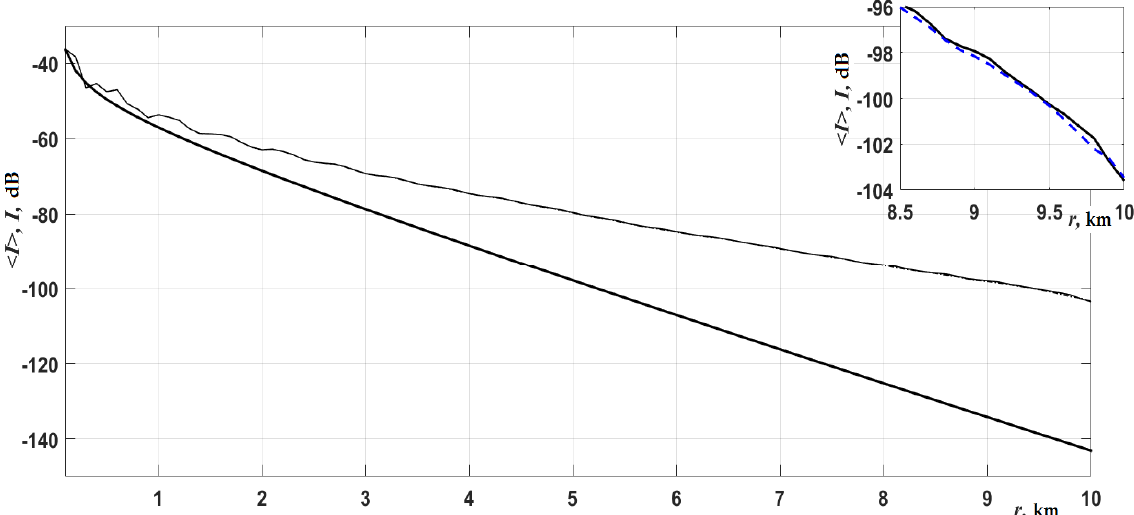
Figure 3. The average intensity (with the opposite sign it is transmission loss) in the waveguide with the random impedance. N = 10 3 . H = 30 m, z = z 0 = 14 m. The upper solid and dashed curves, poorly distinguishable from each other, correspond to the OW solution and adiabatic approximation ( V mn = 0). For a distance of 8.5–10 km, these curves are shown in the inset in the upper right corner of the figure. The lower bold curve is a deterministic solution ( δ c 1 = 0), averaged over spatial oscillations.